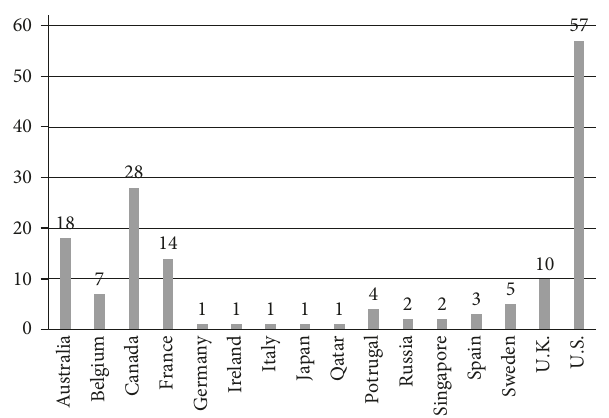
Figure 1: The distribution of the subjects in 16 countries.